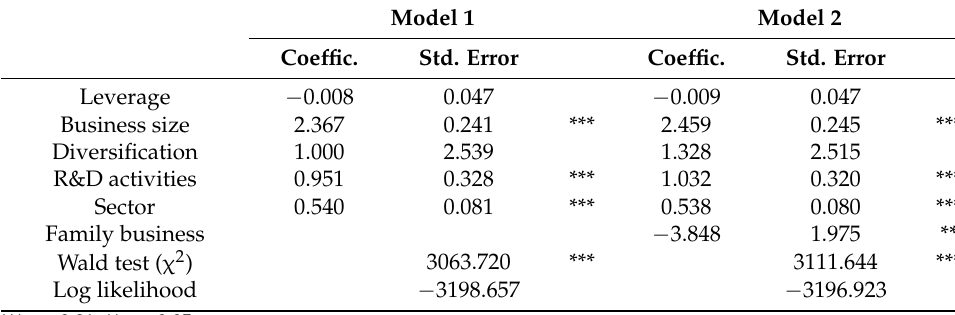
Table 4. Regression models. Early Internationalization.